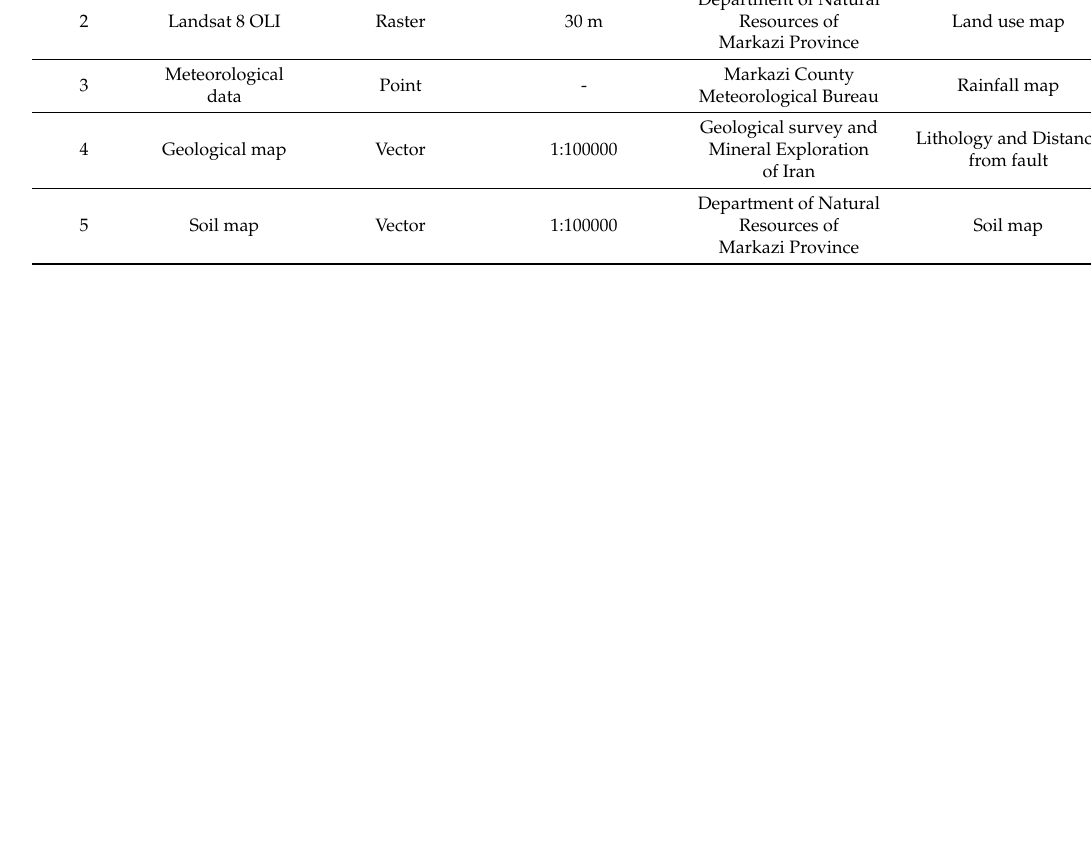
Table 1. Data collection and preparation.